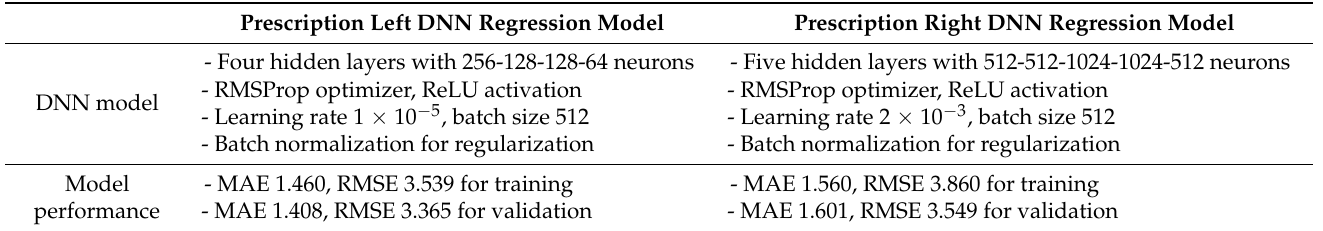
Table 1. Details of the model for determining the foot posture index for the modified root technique.